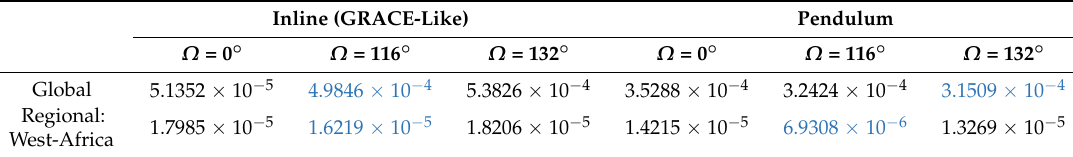
Table 6. Error RMS in terms of geoid height for global and regional (West-Africa) 6-day recovery up to L max = 64 of the scenario (b) inline and Pendulum formations. The smallest values in global and regional cases for each inline and Pendulum formation are written in blue.